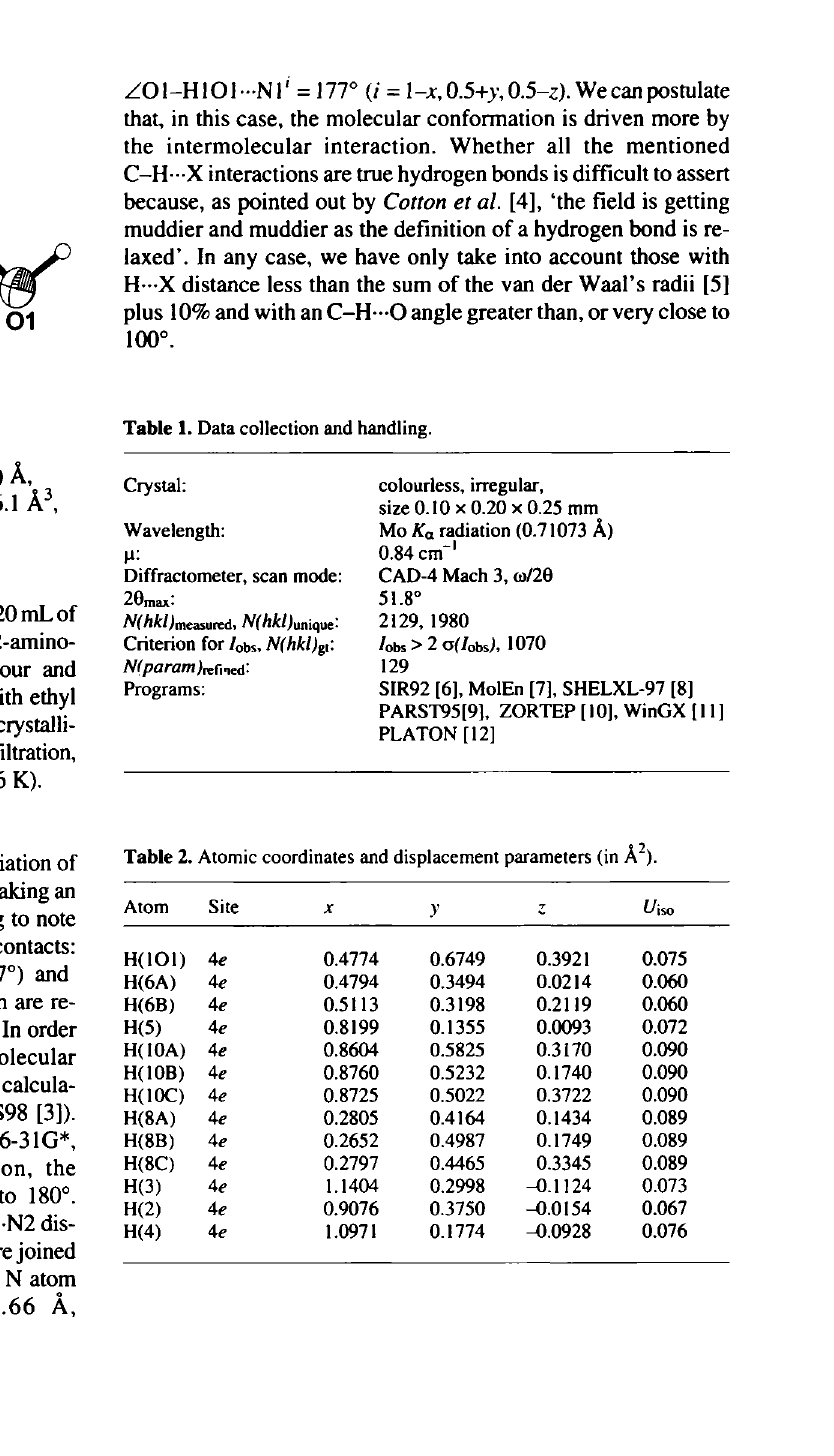
Table 1. Data collection and handling.